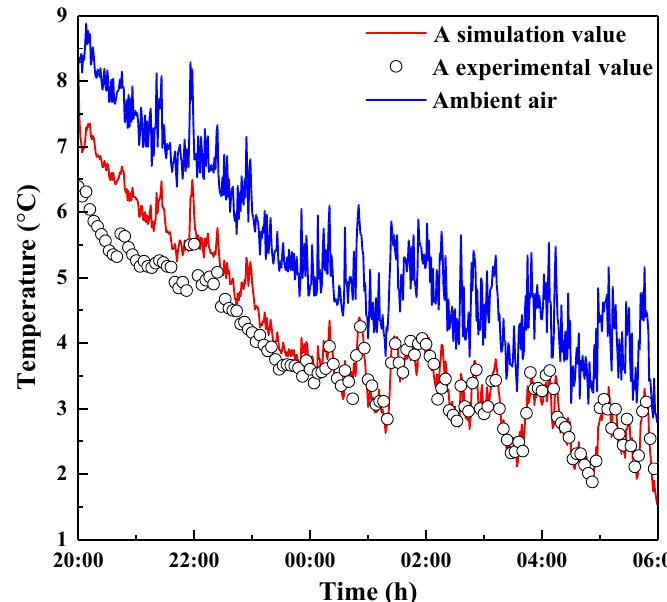
Figure 12. The temperature variation curves of the experimental and simulated values of point A and the ambient surroundings.